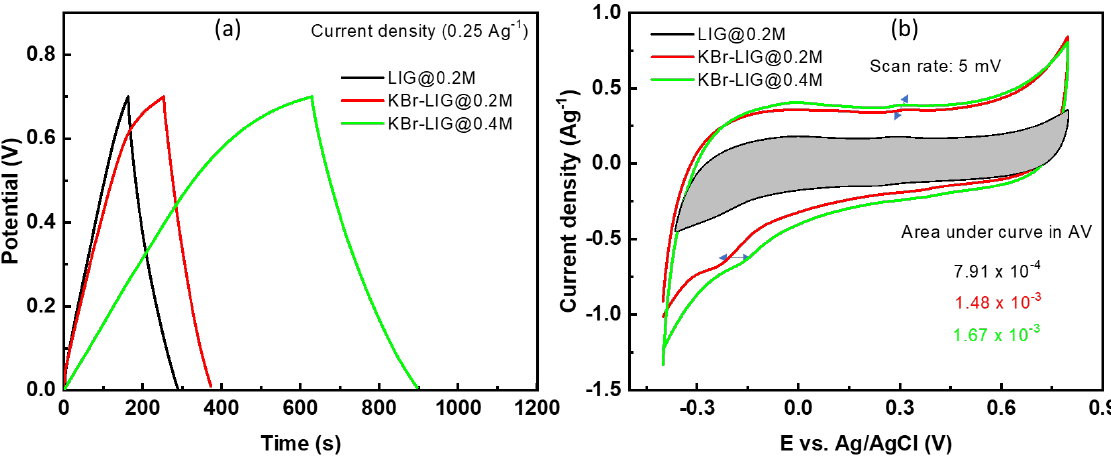
Figure 6. ( a ) GCD curves at a current density of 0.25 Ag −1 , ( b ) CV curves at scan rate 5 mV, for LIG@0.2M, KBr-LIG@0.2M, and KBr-LIG@0.4M.